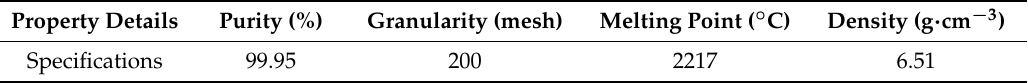
Table 1. Details of La 2 O 3 used in brake